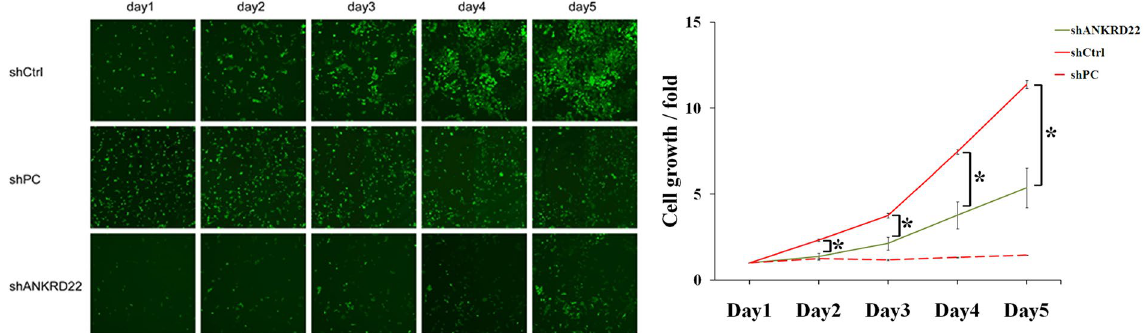
Figure 2. Effect of ANKRD22 on cell growth. H1299 cells transfected with ANKRD22-shRNA (shANKRD22), negative control shRNA (shCtrl) and positive control shRNA (shPC) were observed by High Content Imaging Pathway Celigo for 5 days. The cell growth curve (fold change) indicated that knockdown of ANKRD22 expression significantly inhibited H1299 cell growth. (n = 3, * P < 0.05).